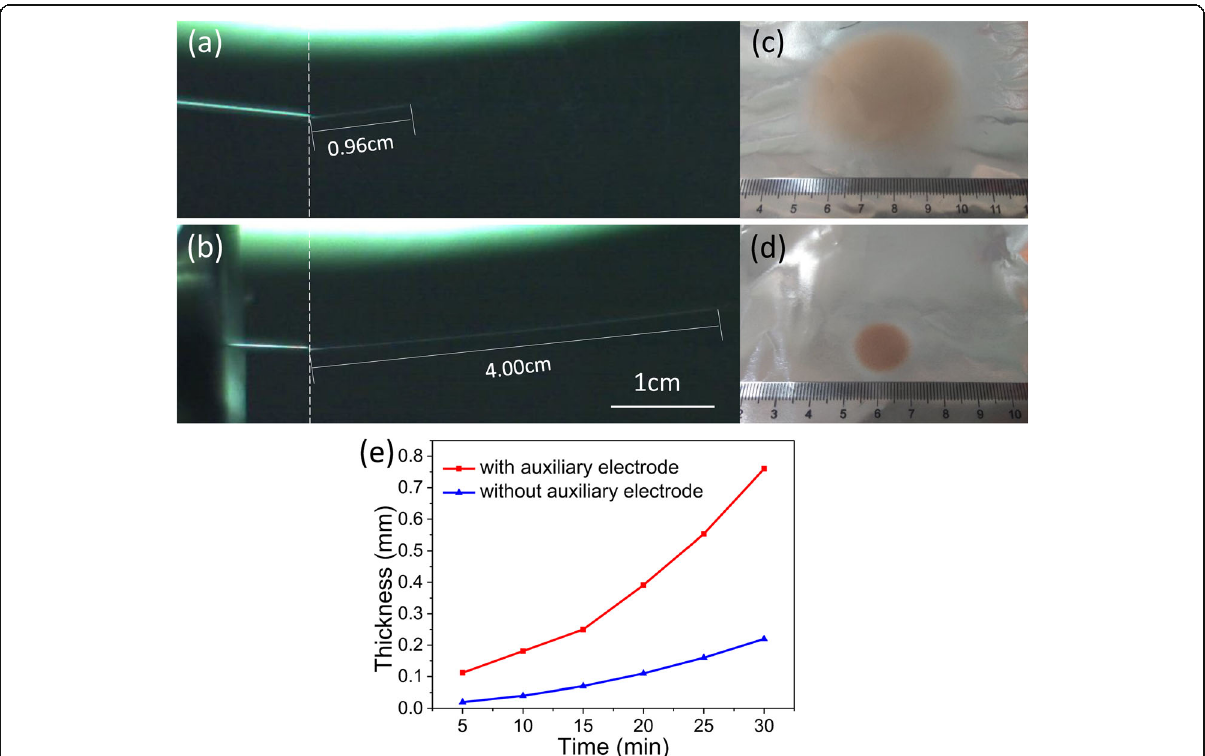
Fig. 2 High-speed camera photos of electrospinning jet at steady zone a without and b with the auxiliary electrode. Optical photographs of in situ deposited electrospun fiber membrane c without and d with the auxiliary electrode. e Time-dependent deposition thickness curves for in situ preparation of electrospun fiber